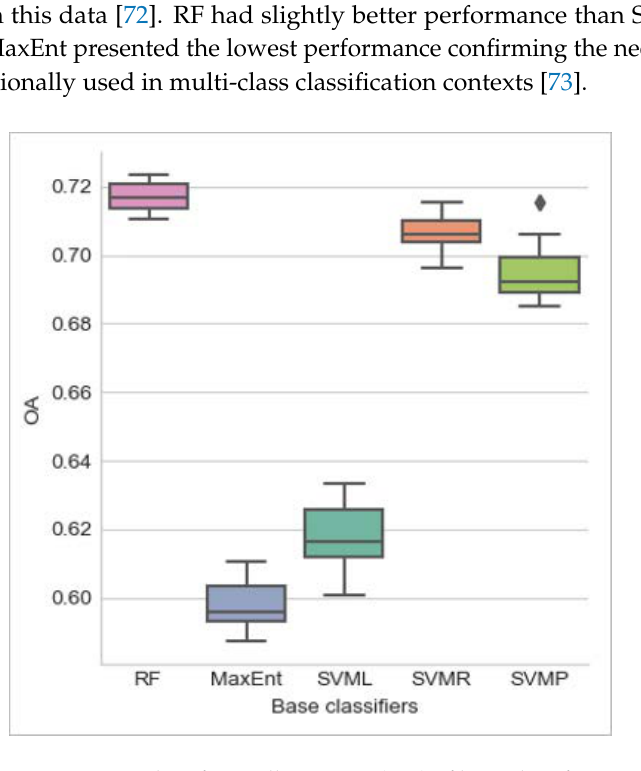
Figure 6. Boxplot of overall accuracy (OA) of base classifiers.